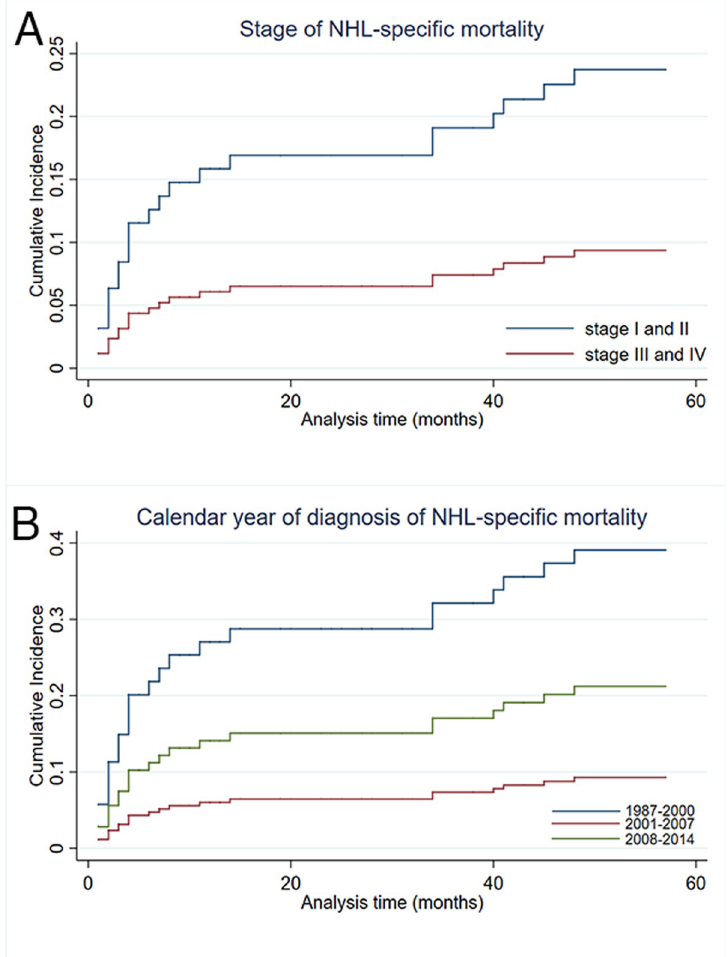
Fig 3. Cumulative incidence plot comparing (A) Ann Arbor stage and (B) calendar year of diagnosis in NHL-specific cause mortality.